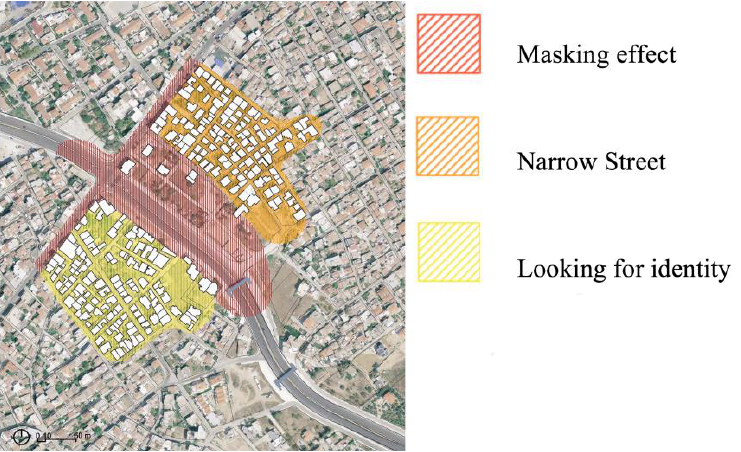
Figure 13. Sound identity map of the Iolkos UA in Volos.